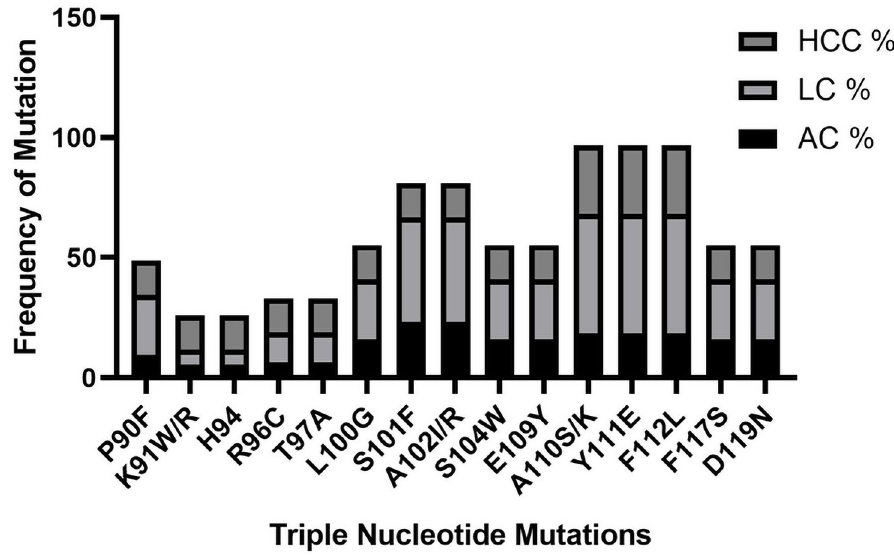
Fig 8. Frequency of triple nucleotide mutations in CH, LC, and HCC groups.